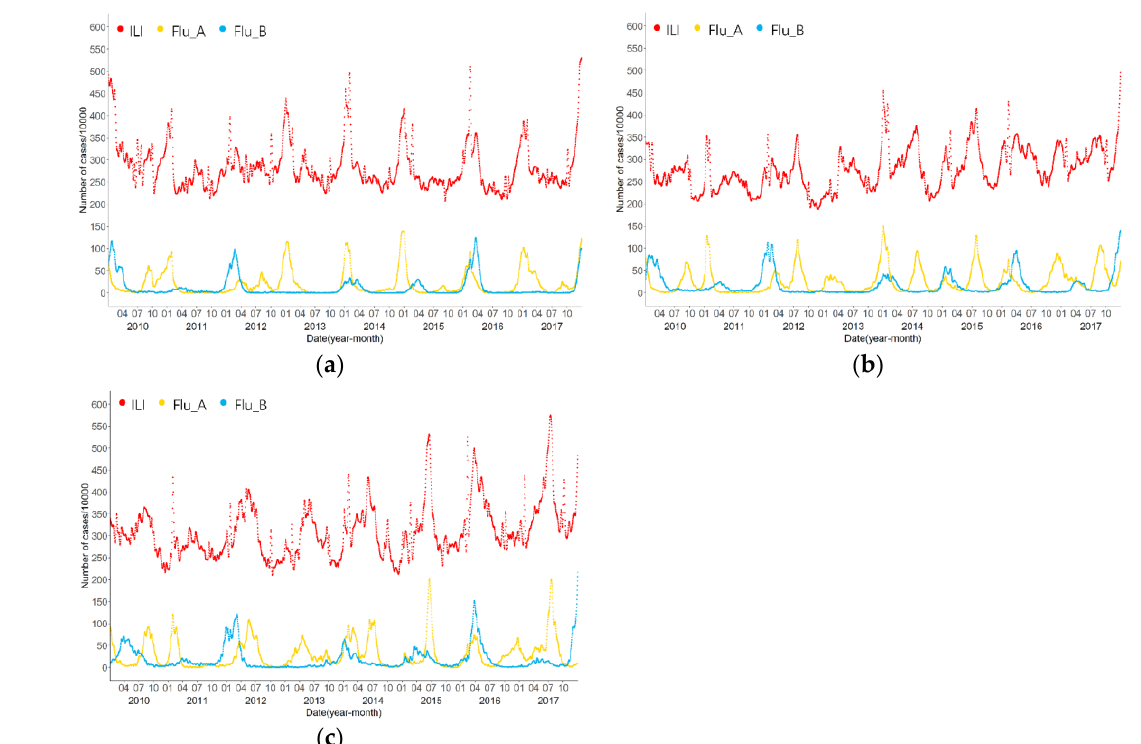
Figure 2. Influenza trends in the three regions of China, 2010–2017. ( a ) Northern China; ( b ) Central China; ( c ) Southern China. The red, yellow, and blue dots show the rate of ILI, the incidence rate of Flu A, and that of Flu B, respectively. Abbreviations: ILI, influenza-like illness; Flu A, influenza A; Flu B, influenza